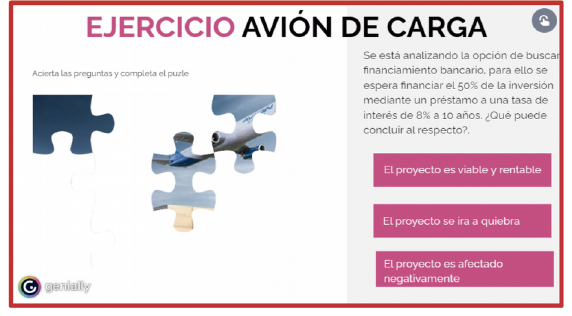
Figure 18. Integrated exercise solution